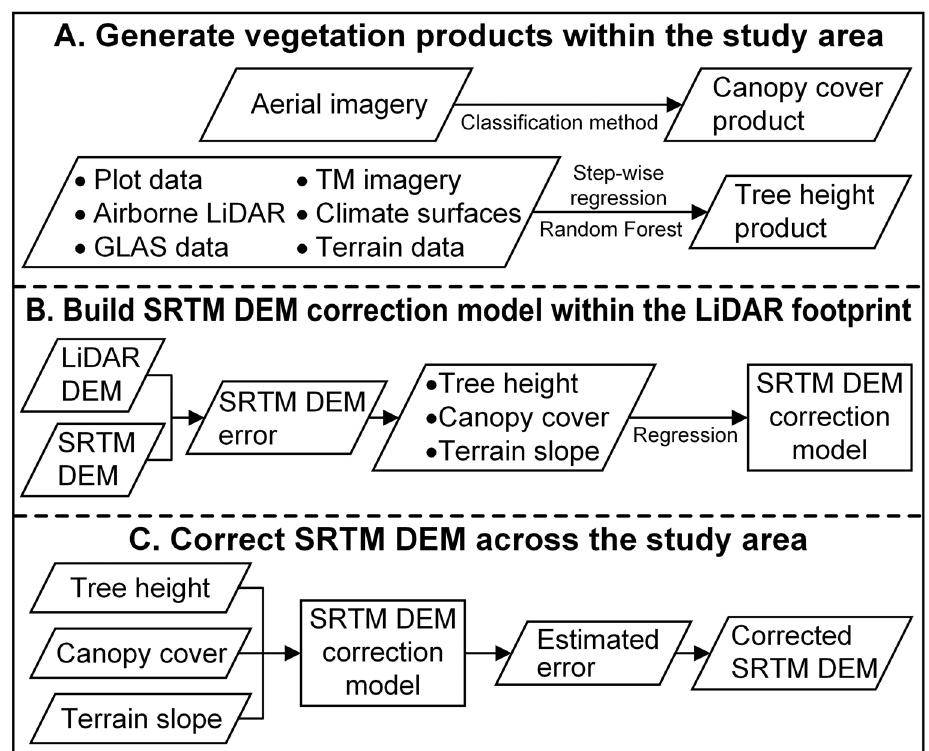
Figure 2. Flow chart of the method to correct the SRTM DEM over vegetated mountain areas in this